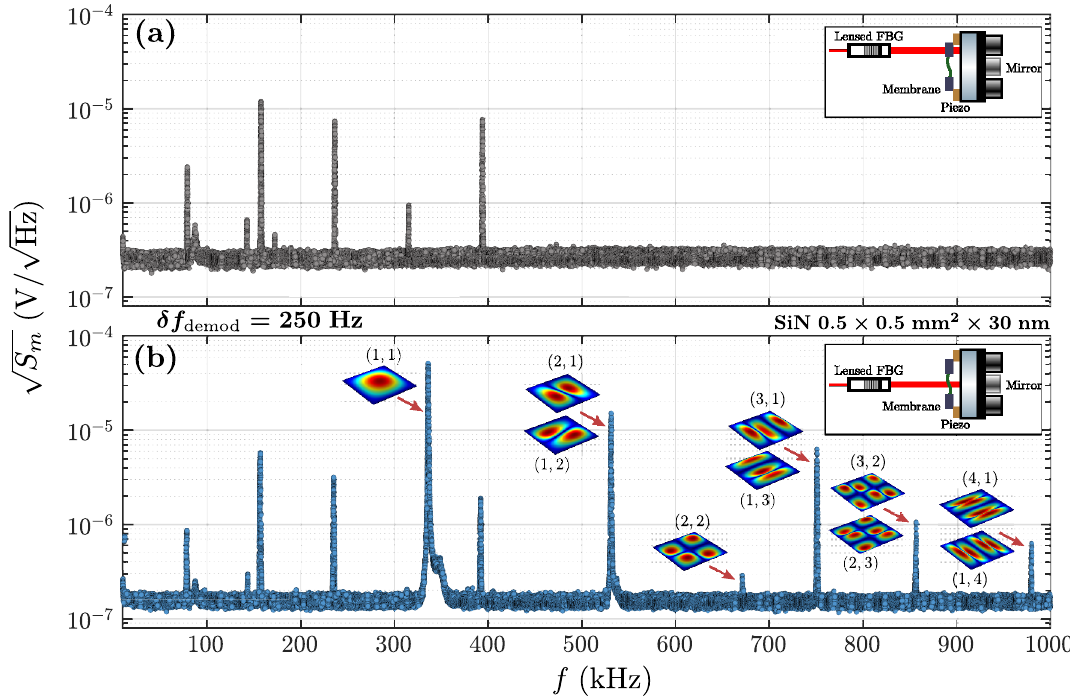
Figure 3. Identification of the resonant mechanical modes of a SiN membrane. ( a ) Measured wide range reference thermomechanical spectrum of the silicon frame (in gray) and ( b ) of the SiN membrane (square 0.5mm 30nm , in blue), in voltage unit (optical PSD). The mechanical modes of interest (i.e. geometry 0.5 × × of the membrane) are identified by comparison with the reference spectrum and shown with red arrows. The ( m , n ) modal indices are indicated. The shapes of each identified mode, calculated by finite element modeling simulation, are depicted. The insets show a schematic of the optical cavity for each measurement.